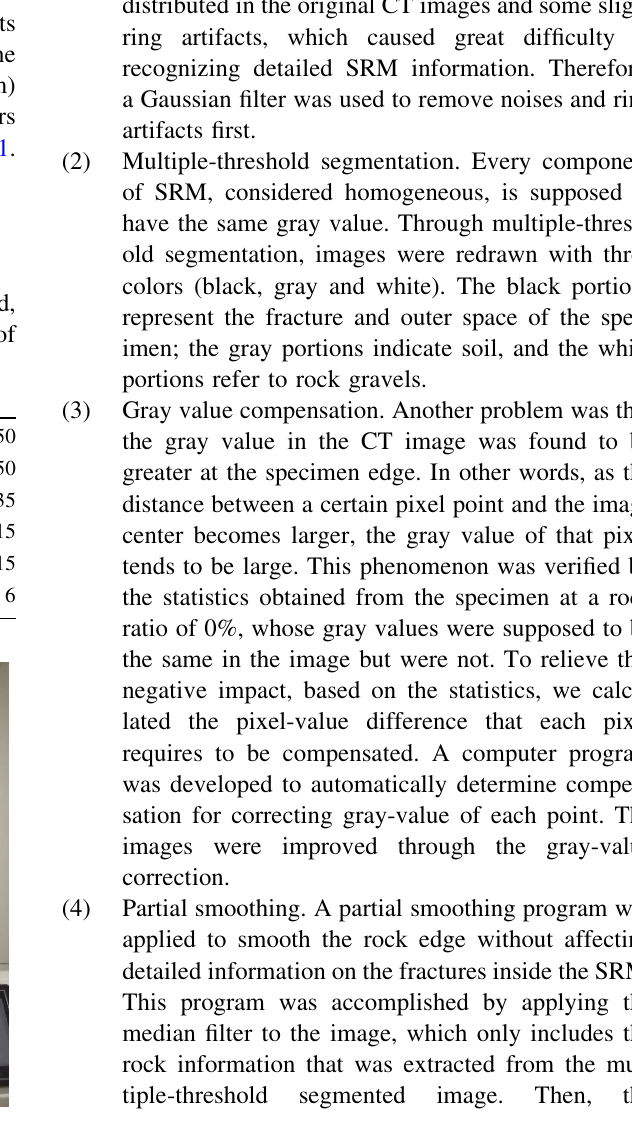
Fig. 1 The loading apparatus mounted on the CT objective stage